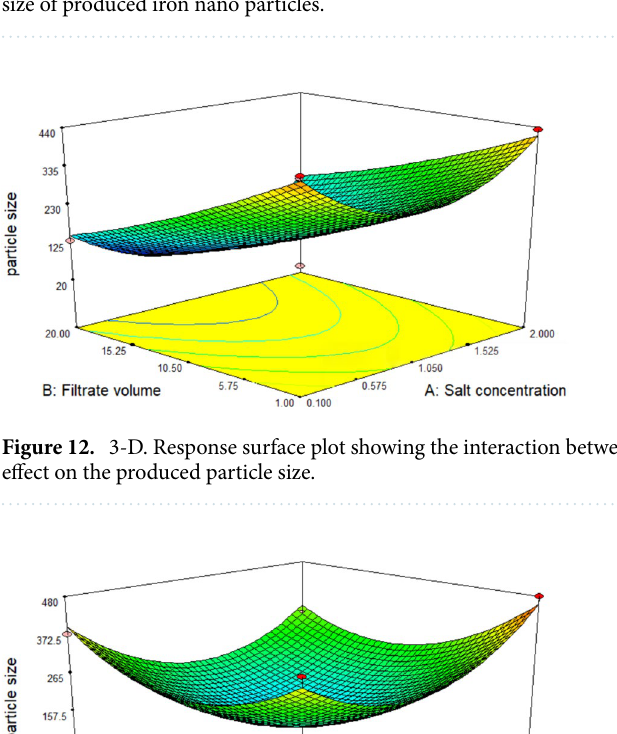
Figure 11. Perturbation plot showing the main effect of A = Salt conc., B = Culture filtrate volume, C = pH on size of produced iron nano particles.